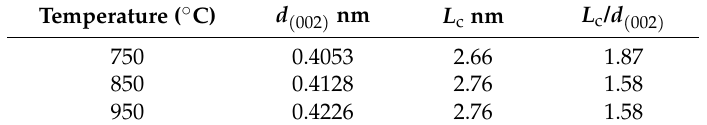
Table 1. The structure parameters determined by X-ray diffraction for the PAN carbon fibers.